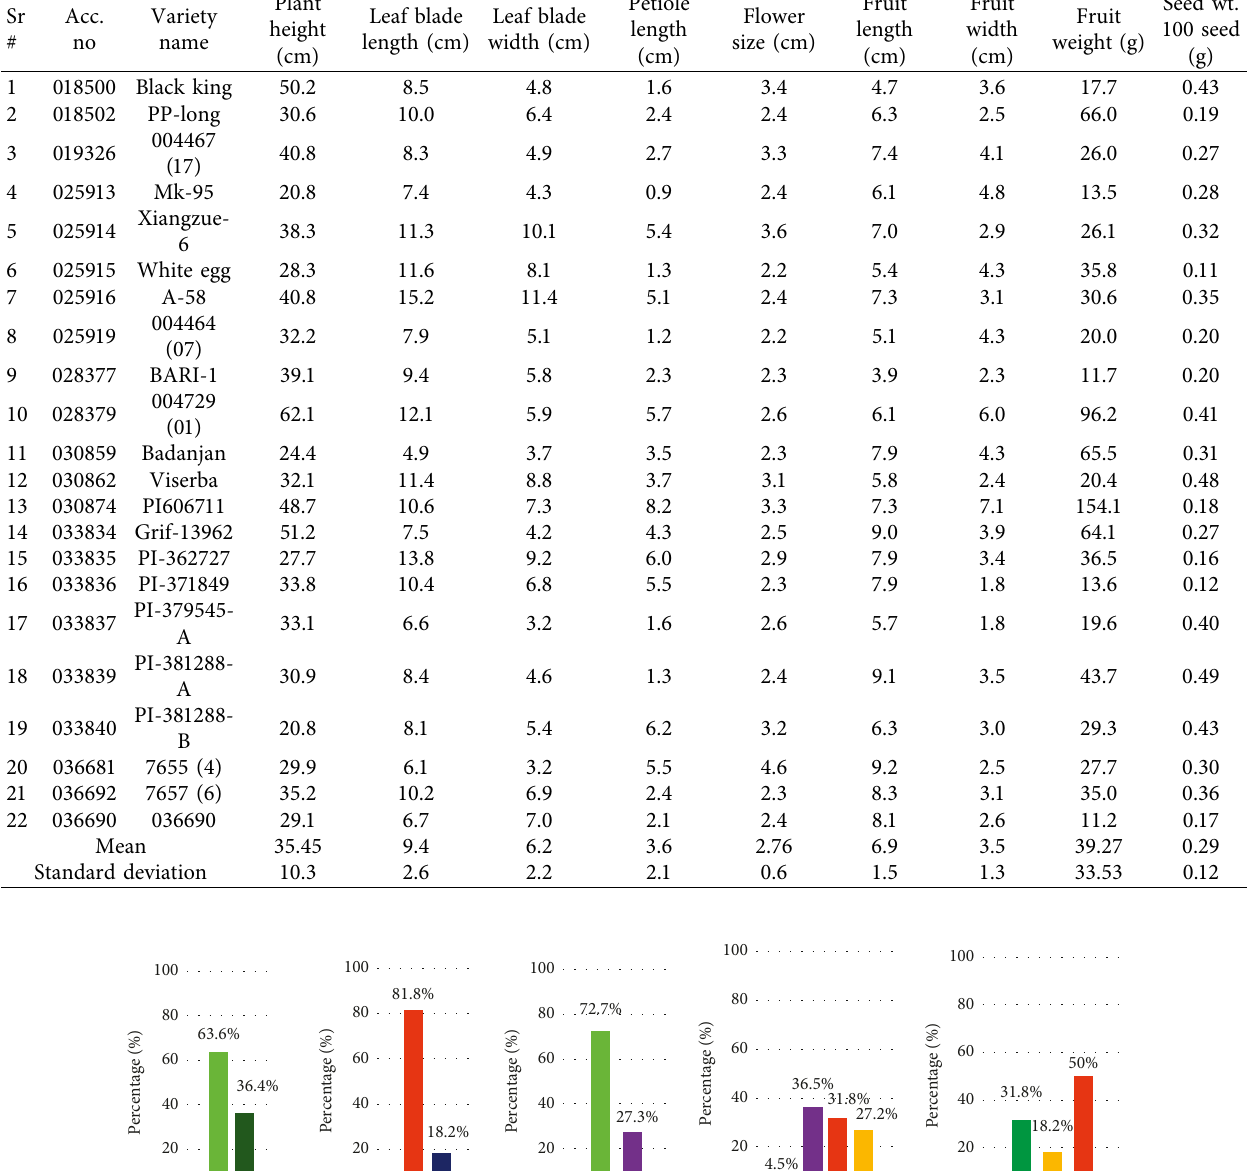
Table 3: The mean value and SD taken for 9 quantitative descriptors of 22 eggplant accessions.